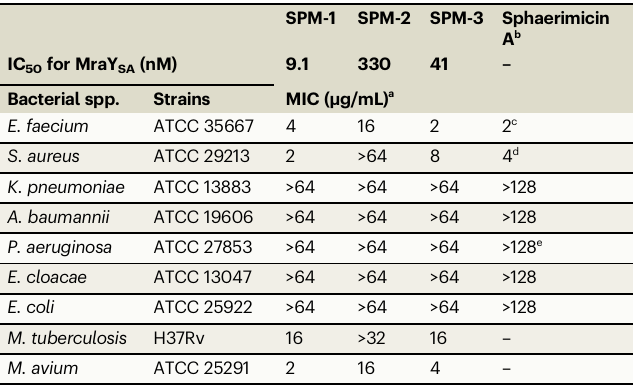
Table 1 | Antibacterial activity of SPMs against